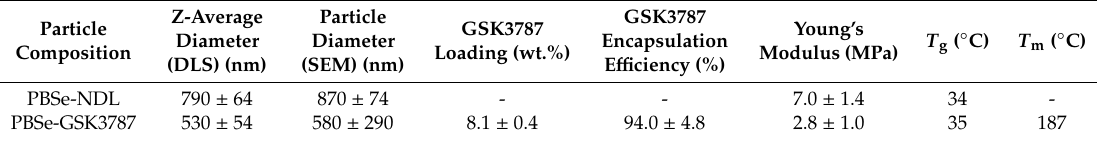
Table 1. Physicochemical properties of PBSe-GSK3787 and PBSe-NDL particles. Particle